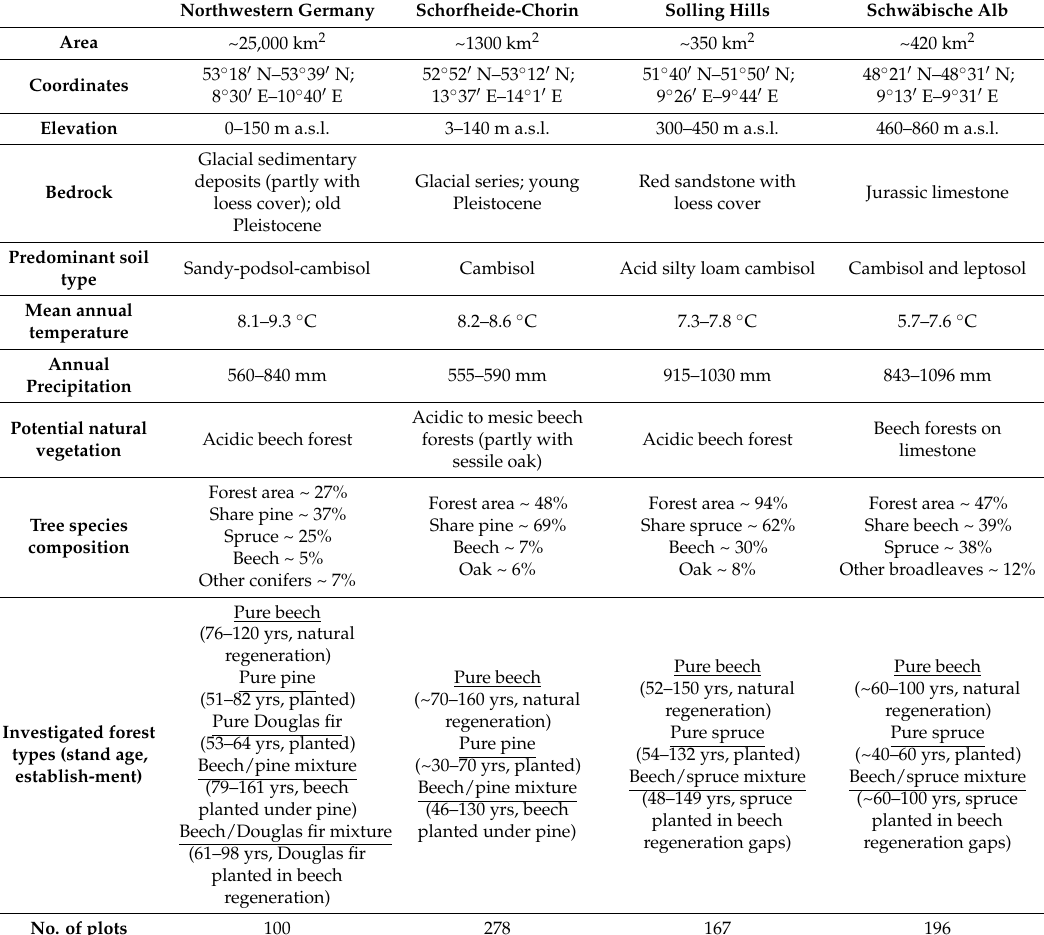
Table 1. Characteristics of the study regions. Data are based on information on forest growth regions and districts provided by Gauer and Aldinger